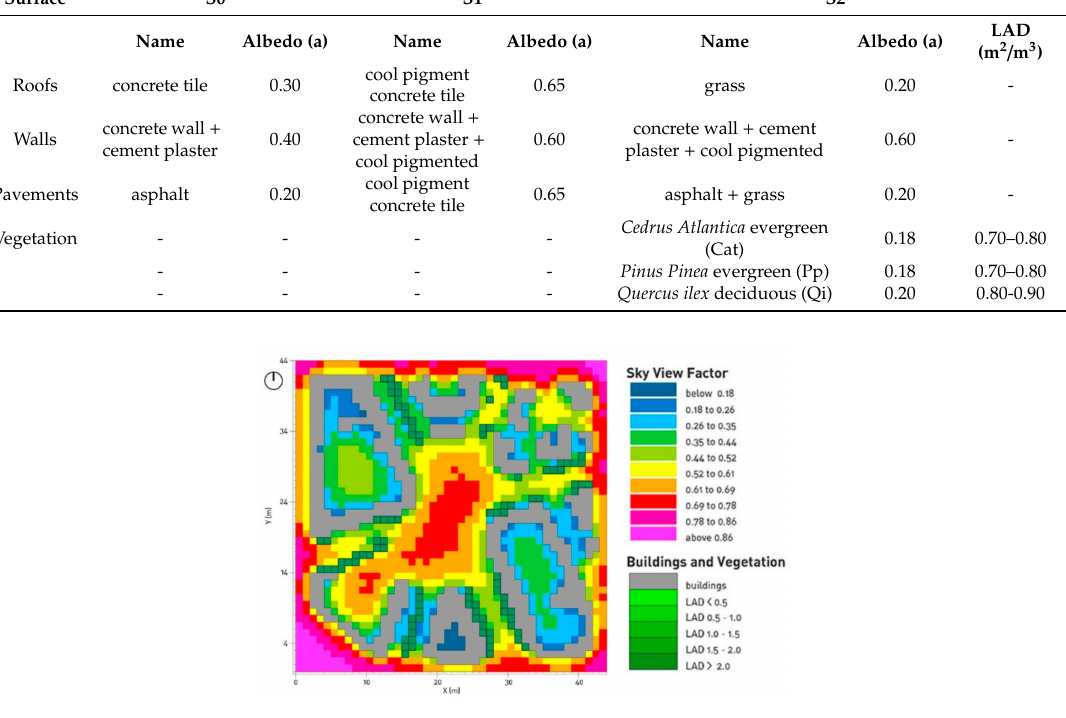
Figure 3. Piazza Bainsizza reference area: Sky view factor distribution and Leaf Area Density (analysis software: ENVI-met 3.1).